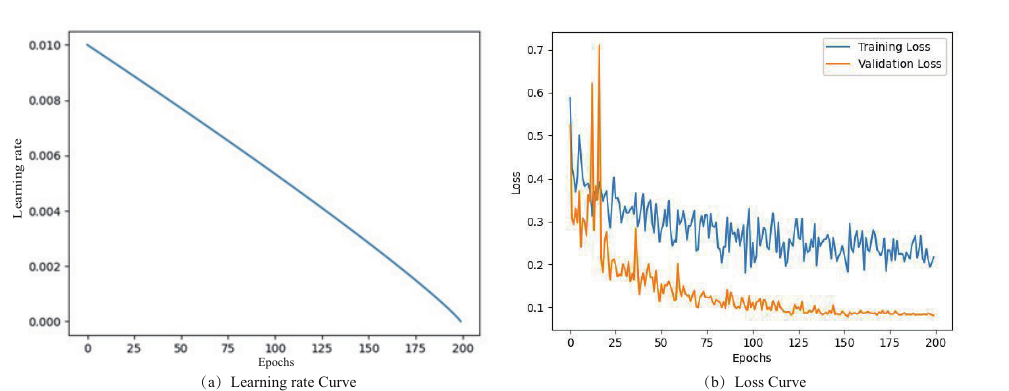
Figure 6. Learning rate curve and loss